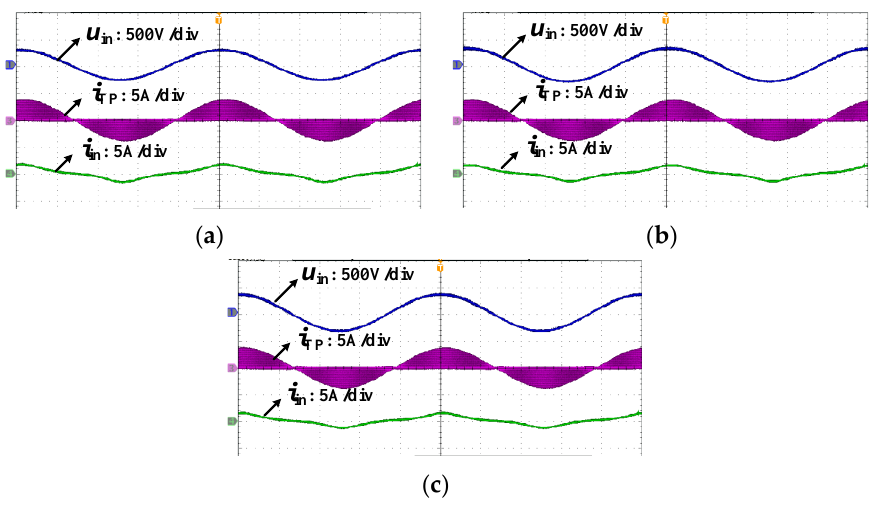
Figure 19. The measured waveforms of input current i in after filtered and current i TP at different input voltages. ( a ) u in = 198 V. ( b ) u in = 220 V. ( c ) u in = 242 V.